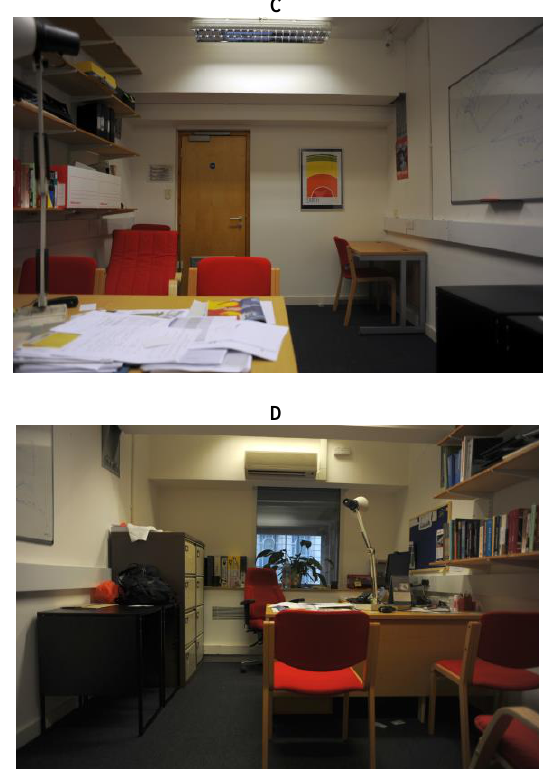
Figure 1. Views of the corridor as illustrated in Figure 2